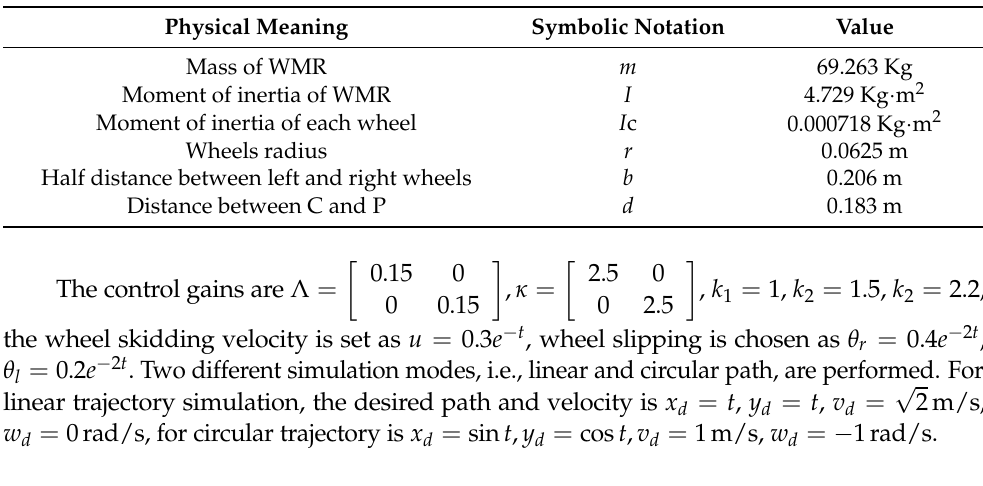
Table 1. Parameters of the studied WMR